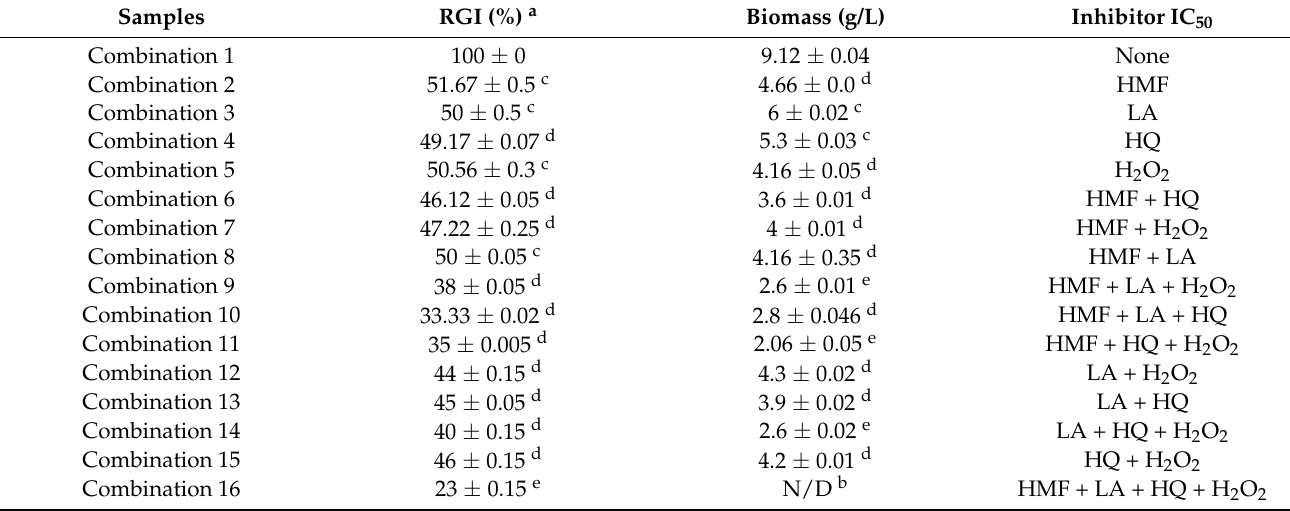
Table 3. Effect of inhibitor combinations on mycelial growth and biomass accumulation of Colletotrichum sp.